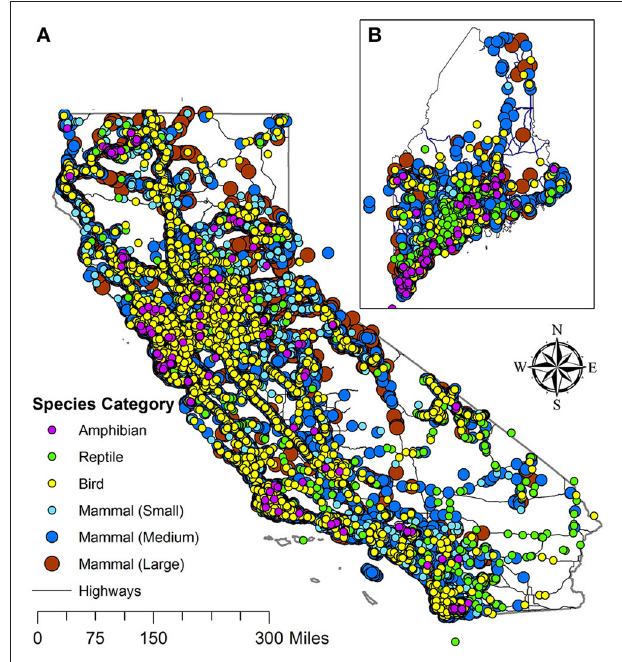
FIGURE 2 | Distribution of all wildlife observations (circles) in California (A) and Maine (B)